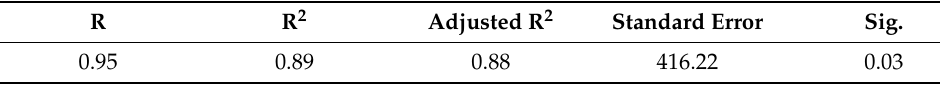
Table 15. Summary of models for mixed sites.